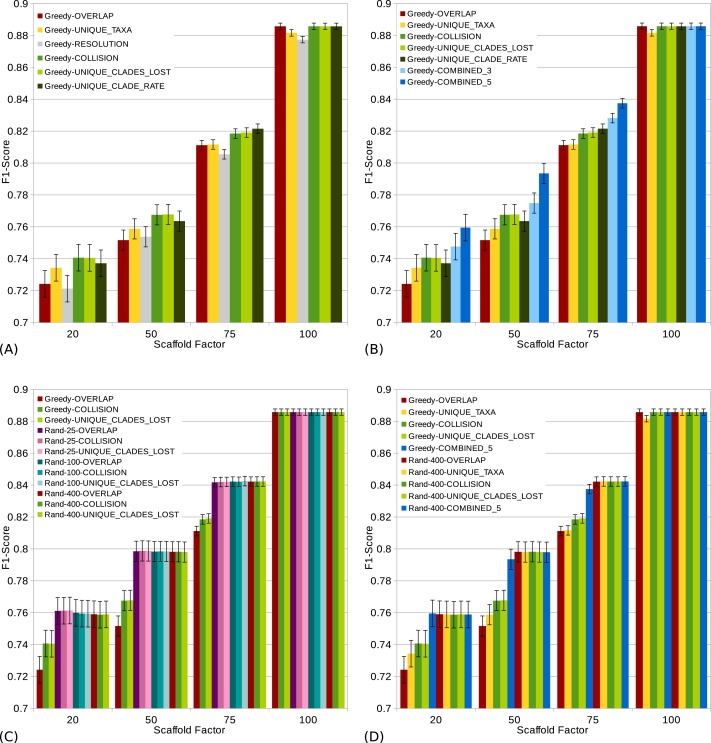
\documentclass[12pt]{minimal}
\usepackage{amsmath}
\usepackage{wasysym}
\usepackage{amsfonts}
\usepackage{amssymb}
\usepackage{amsbsy}
\usepackage{upgreek}
\usepackage{mathrsfs}
\setlength{\oddsidemargin}{-69pt}
\begin{document}
}{}${\mathit{F}}_{1}\text{-score}$\end{document}F1-scores (a high score is good) of different scoring functions (including combined scorings) with and without randomization for all scaffold factors (20%, 50%, 75%, 100%) of the 1,000 taxa dataset.The Combined scorings are the semi-strict consensus of the supertrees calculated by the respective scorings. The integer value after the keyword “Rand” represents the number of randomized iterations. The error bars show the standard error. (A) Comparison of single scoring functions (Overlap, Unique-Taxa, Resolution, Collision, Unique-Clades-Lost, Unique-Clades-Rate). (B) Comparison of single scoring functions (Overlap, Unique-Taxa, Collision, Unique-Clades-Lost, Unique-Clade-Rate) and their combinations (Combined-3,Combined-5). (C) Comparison of different scoring functions (Overlap, Collision, Unique-Clades-Lost) with (25, 100 and 400 random iterations) and without randomization. (D) Comparison of single (Overlap, Unique-Taxa, Collision, Unique-Clades-Lost) and combined (Combined-5) scorings. Both with 400 random iterations and without randomization.